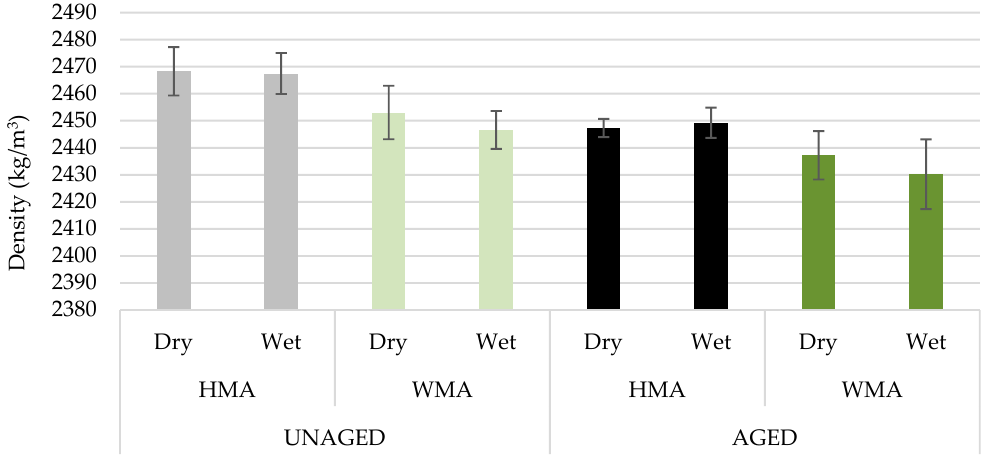
Figure 3. Average bulk densities of water sensitivity tests’ specimens.